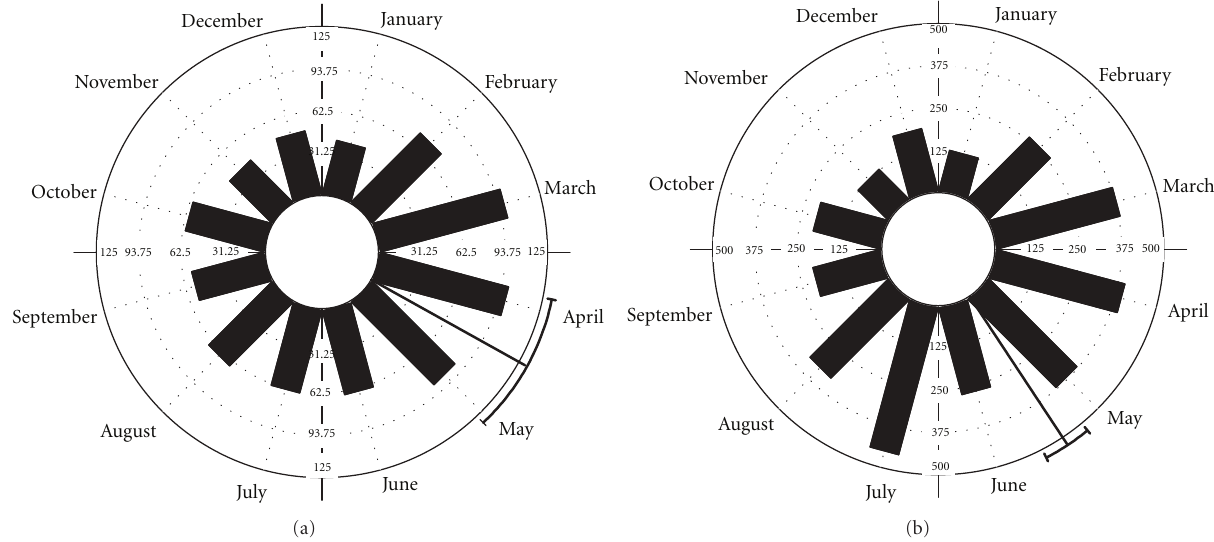
Figure 1: Circular analysis of resource availability during one year (March 2010 to February 2011) in the University campus. (a) Number of species in bloom. (b) Number of individuals in bloom. Each month represents 30 ◦ of the circle, and each bar represents the number of flowering species and individuals, respectively. The line at the top of the vector indicates the standard deviation.